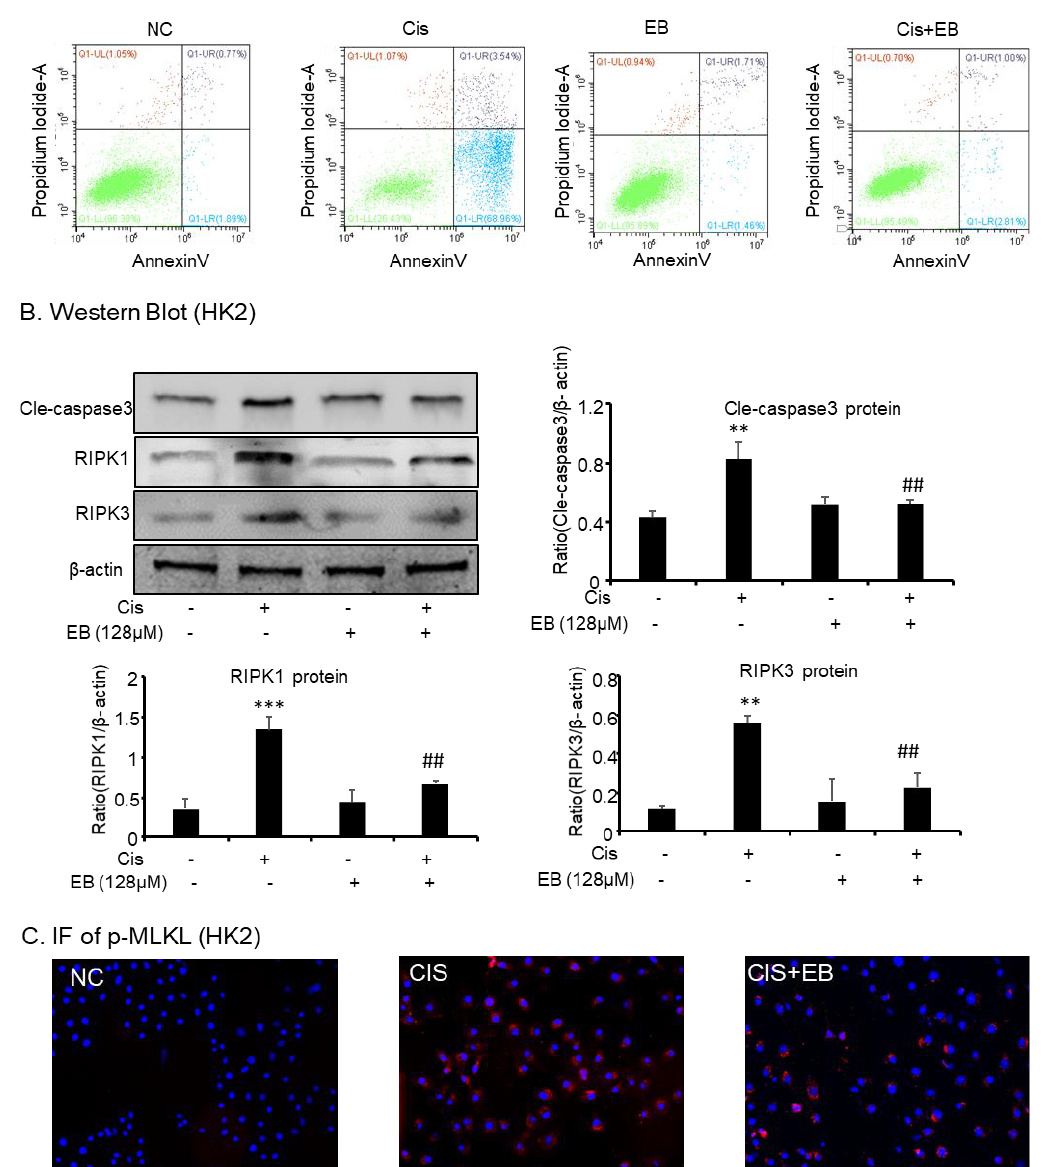
Figure 3. Eleutheroside B attenuated programmed cell death induced by cisplatin in HK-2 cells. ( A ) Flow cytometry in HK-2 cells. ( B ) Western blotting analysis of programmed cell death-related molecules. ( C ) Immunofluorescence of phosphorylated-mixed lineage kinase domain like in HK-2 cells. Eleutheroside B significantly downregulated receptor-interacting protein kinase (RIPK)1, RIPK3, p-mixed lineage kinase domain-like protein (p-MLKL), and apoptosis-related protein cle-caspase3 in cisplatin-treated HK-2 cells. Data represent the mean ± SEM for 3–4 independent experiments in vitro. ** p < 0.01, *** p < 0.001 compared to normal; ## p < 0.01, ### p < 0.001 compared to model. Cis, cisplatin; EB, Eleutheroside B.